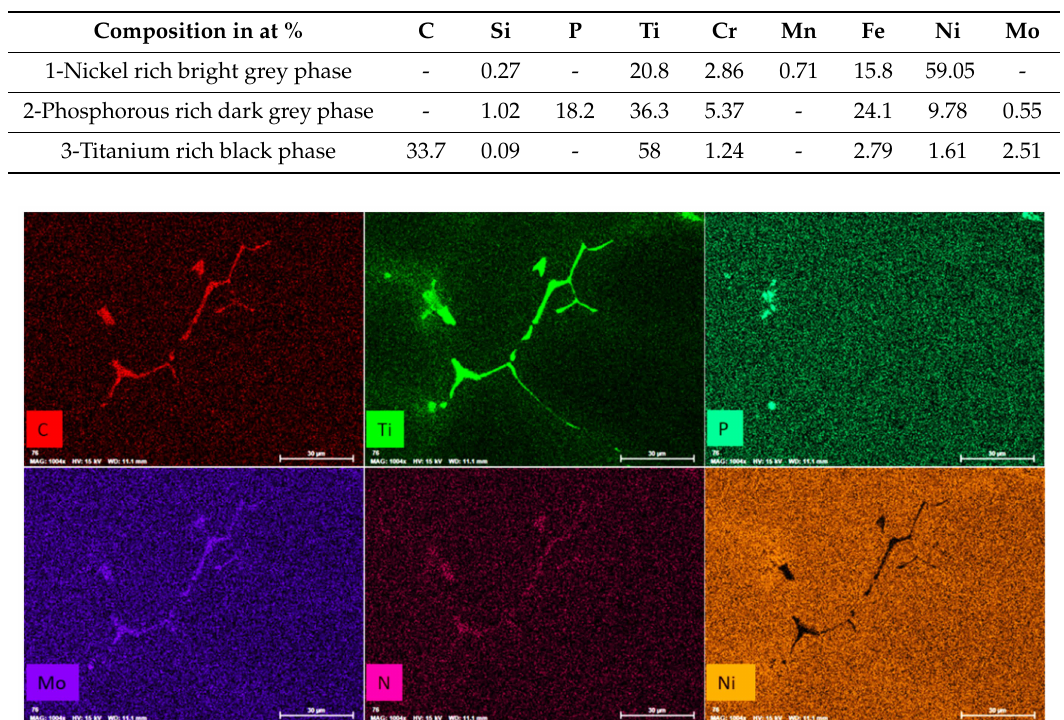
Figure 10. Images of common precipitates. Table 2. X-ray spectroscopy (EDX) spot analysis result shown in atom%.